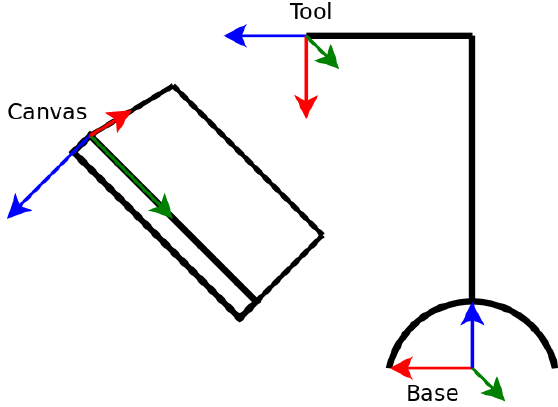
Figure 13. The coordinate systems used by